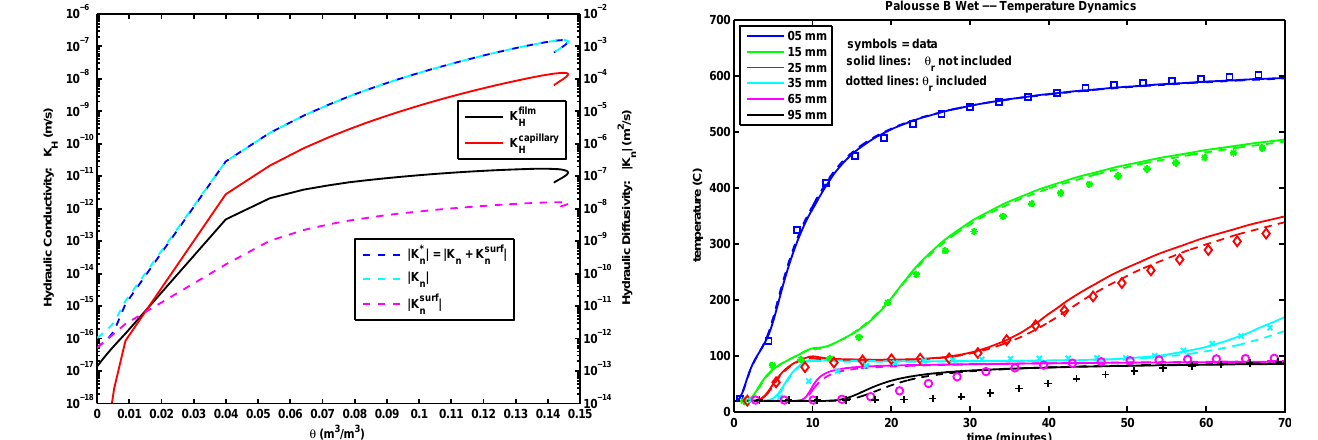
symbols = data solid lines: θ r not included dotted lines: θ